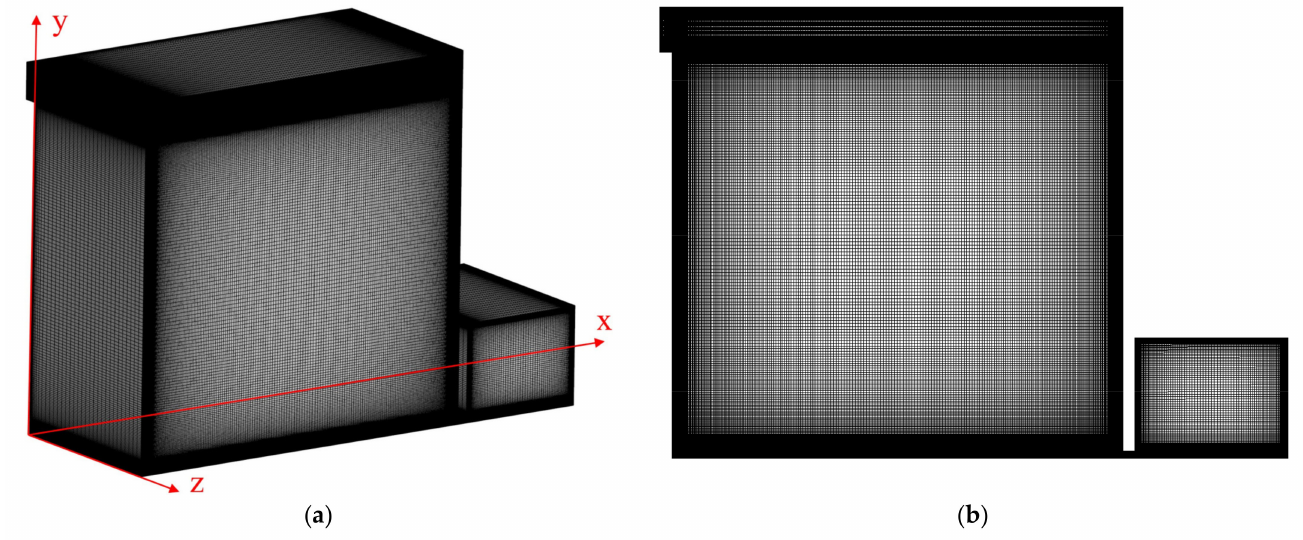
Figure 2. ( a ) Computational grid distribution; ( b ) grid in xy